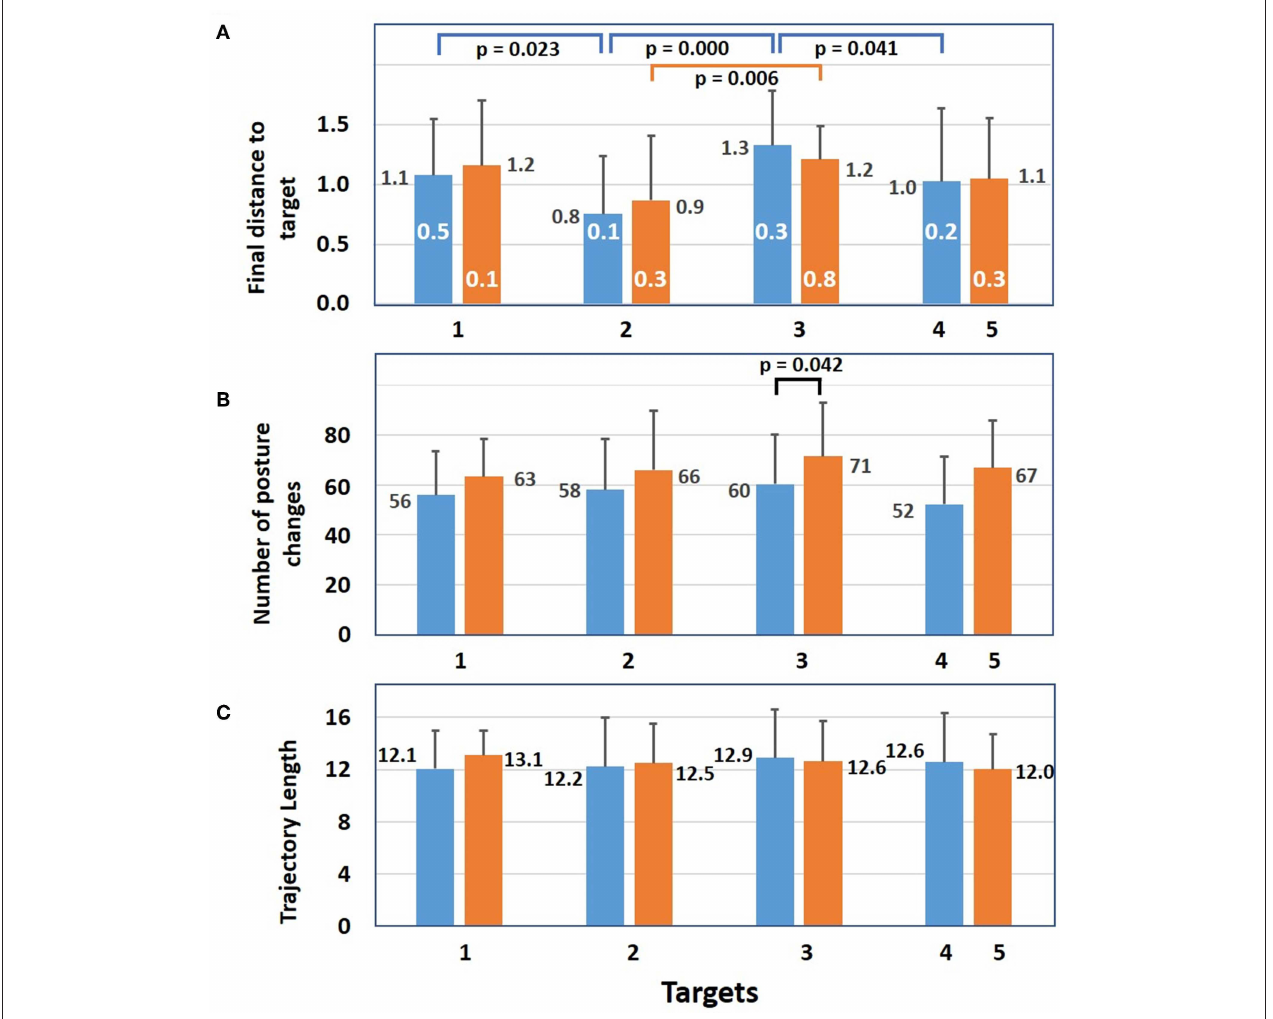
FIGURE 8 | Results of failed trials. (A) Mean distance ( + sd) between the red sphere and a target at 120s for 5 (blue bars) and for eight static postures (orange bars). White numbers represent the minimum distance between the red sphere and a target at 120s. For the 5 SP condition, differences between targets 1 and 2, targets 2 and 3, and targets 3 and 4 are significant. For the 8 SP condition, the difference between targets 2 and 3 is significant. (B) Mean number of posture changes at the end of each trial. For target 3 the difference between 5 and 8 SP conditions is significant. (C) For each target, the mean trajectory length of the red sphere during 120s (independent samples t -test significance is p ≤